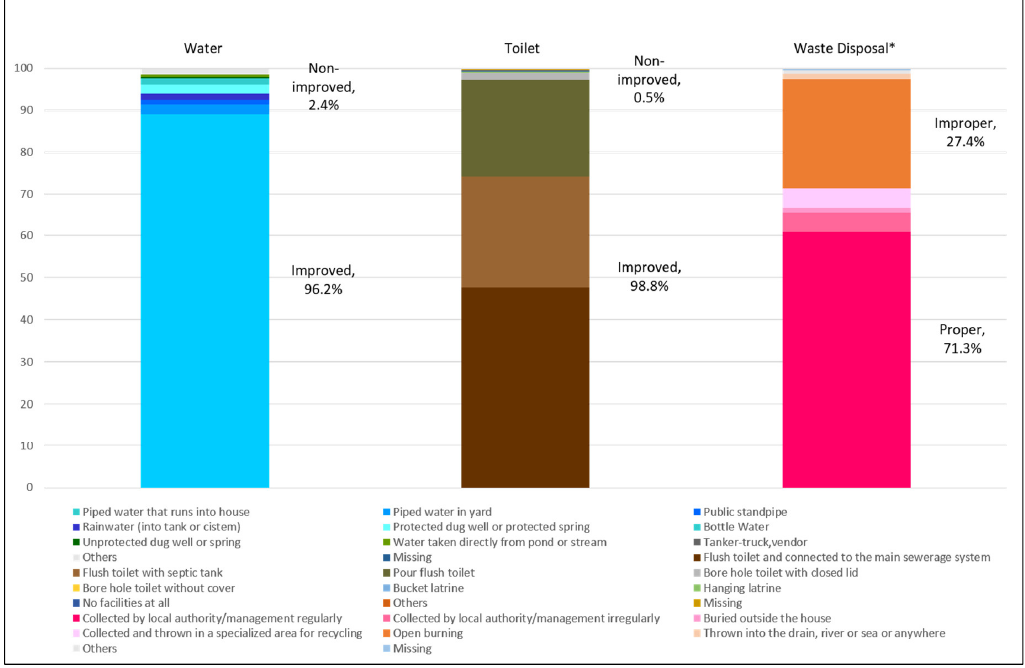
Figure 2. Distribution of improved and non-improved water sources, toilet types and domestic waste disposal.